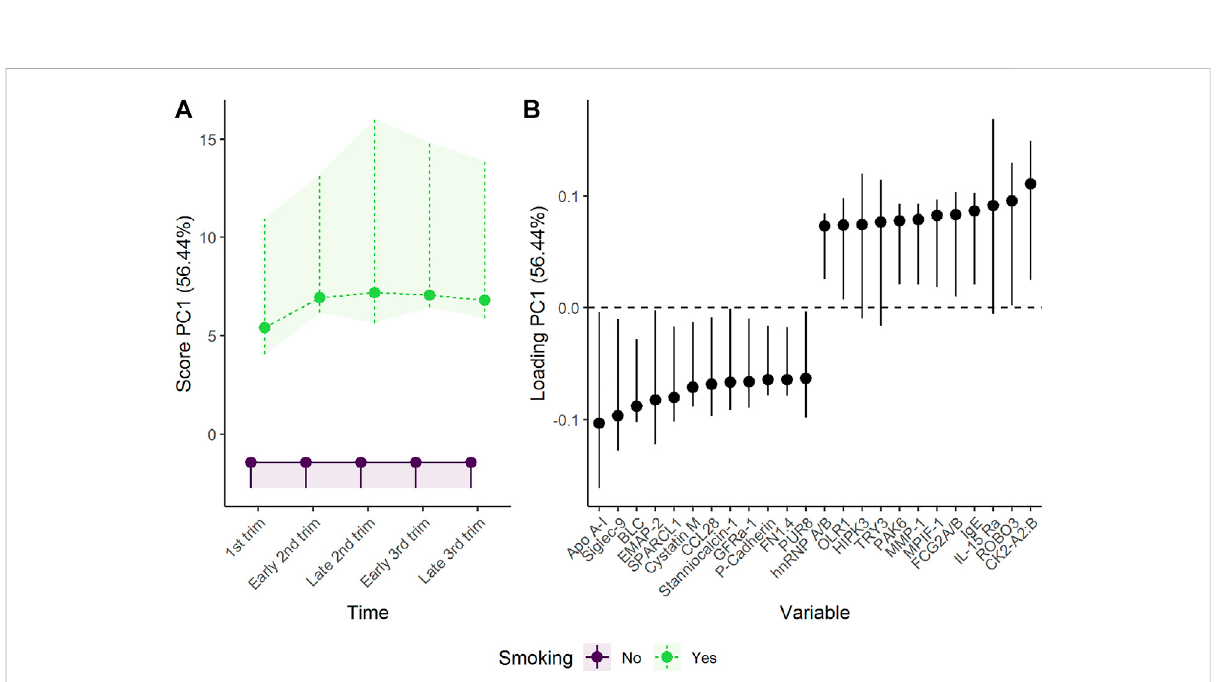
FIGURE 5 Time development of the plasma proteome throughout pregnancy in smoking and non-smoking women as (A) scores and (B) loadings. The timedevelopmentofthenon-smokingwomenhasbeenremovedtohighlighttheeffectofsmoking.Theplasmalevelofproteinswithhighloadingis increasing when the scores increase and vice versa . Only the 12 proteins with highest and lowest loadings, separated by the vertical dotted line, are shown due to the large number of assessed